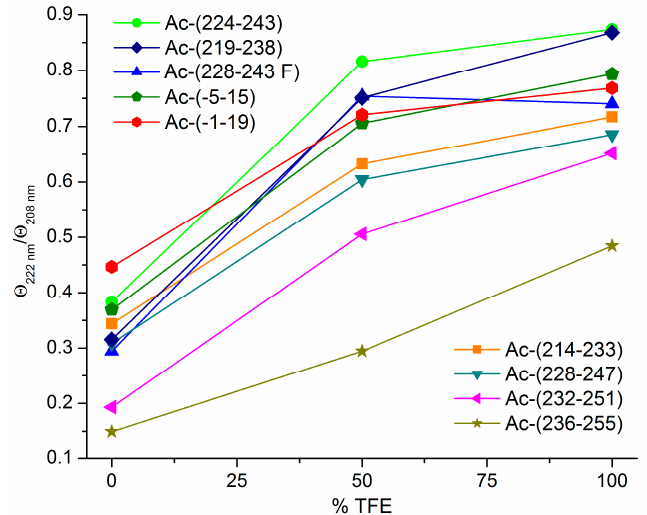
Figure 4. Ratio of Θ 222 nm / Θ 208 nm as a function of TFE concentration for acetylated HSV peptides.